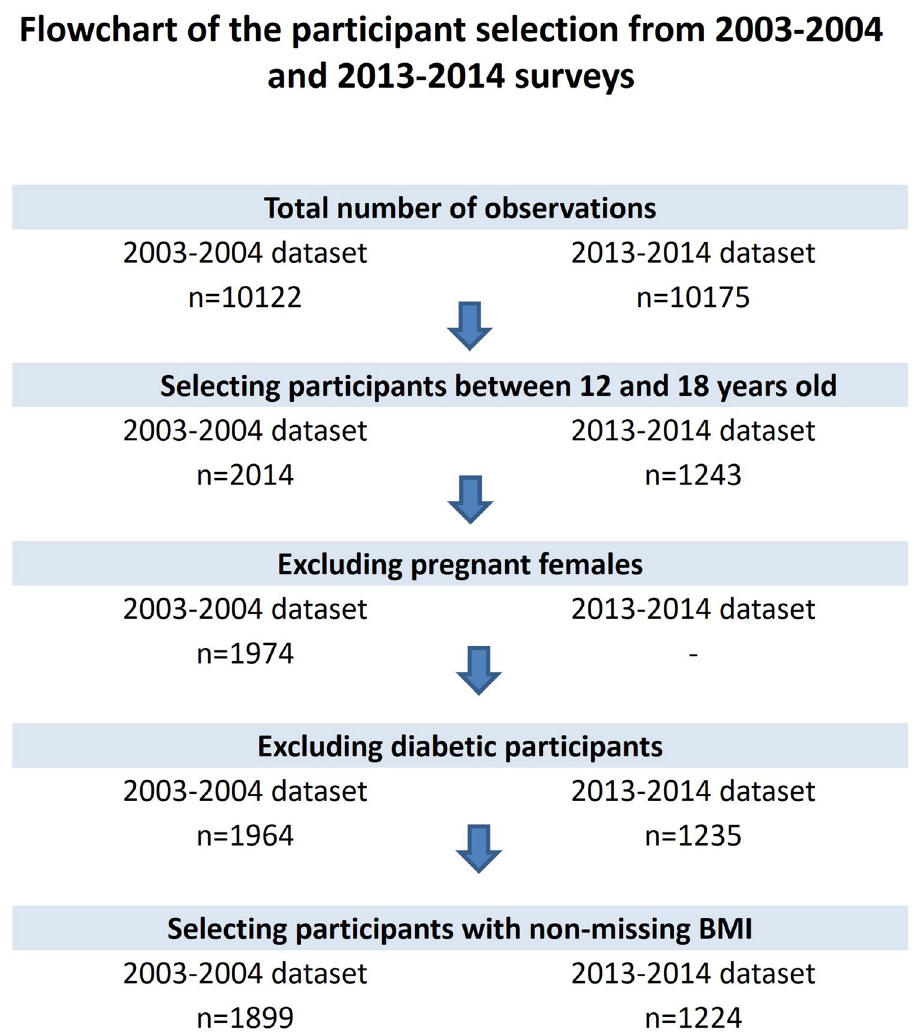
Figure 2. Flowchart of the participant selection from 2003–2004 and 2013–2014